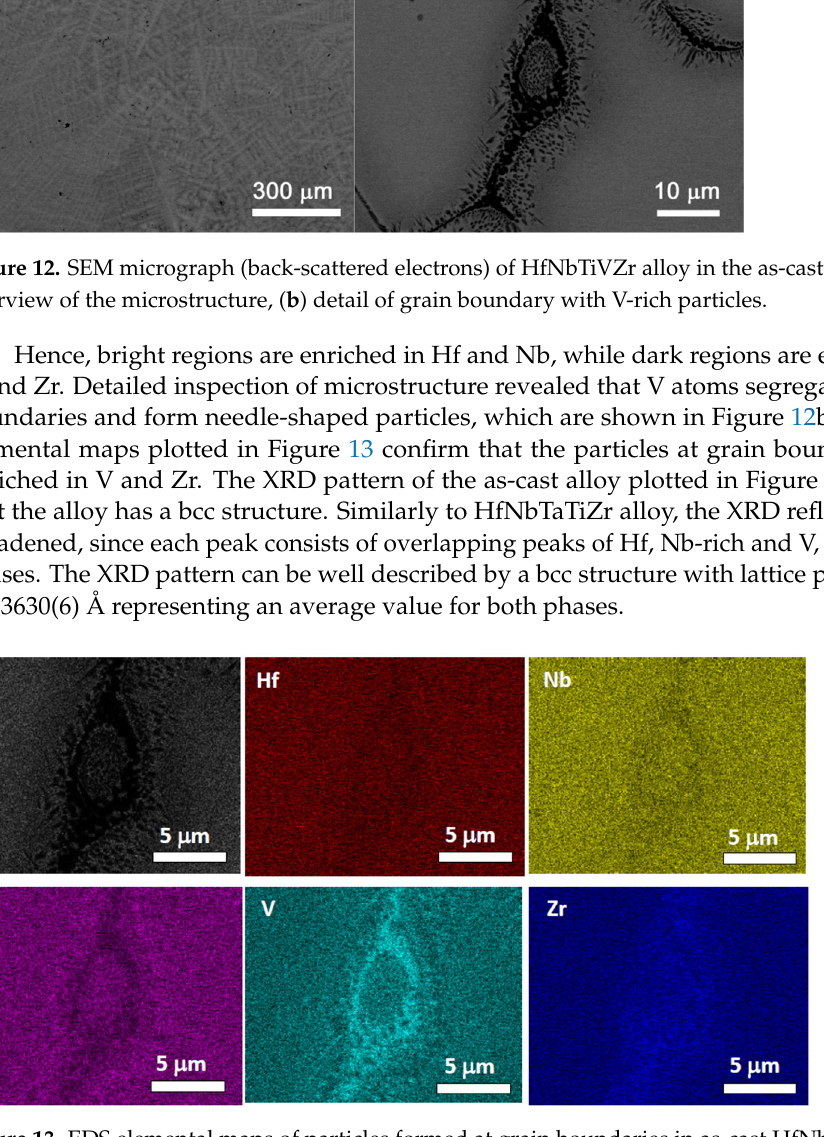
Figure 13. EDS elemental maps of particles formed at grain boundaries in as-cast HfNbTiVZr alloy (SEM micrograph in the upper left panel shows the inspected region).